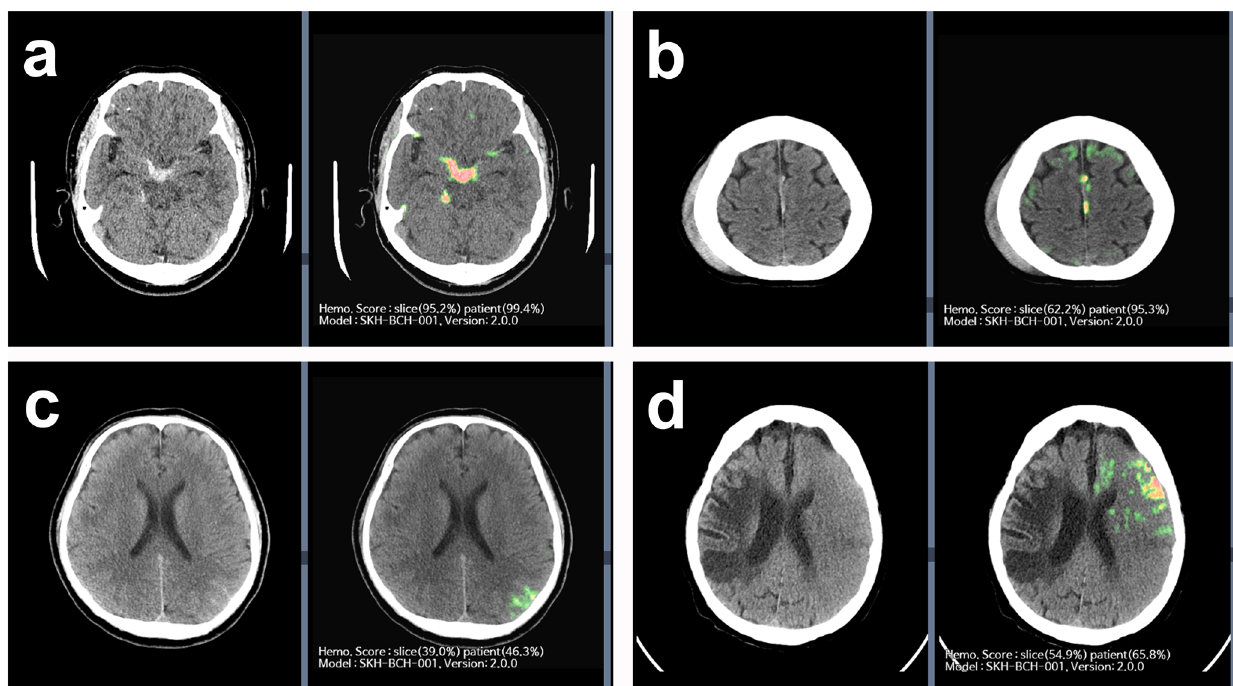
Fig. 3 Representative images of AIH detection. a AI-assisted brain CT revealed probable AIH location as the basal cistern and right ambient cistern. AI-assisted brain CT provided AIH probability scores in a slice-wise (95.8%) and patient-wise (99.4%) manner. All nine reviewers agreed with the AIH diagnosis for both AI-unassisted and AI-assisted interpretations. b AI-assisted brain CT revealed the probable AIH location as the left side of the falx. AI-assisted brain CT provided the AIH probability scores in a slice-wise (62.2%) and patient-wise (95.3%) manner. For interpretation without AI assistance, one reviewer (non-radiologist physician) missed this case of AIH on the left side of the falx. All nine reviewers agreed with the AIH diagnosis for both AI-unassisted and AI-assisted interpretations. c AI-assisted brain CT revealed probable AIH location as the left parietal sulci. AI-assisted brain CT provided AIH probability scores in a slice-wise (39.0%) and patient-wise (46.3%) manner. For interpretation without AI assistance, two-thirds of the reviewers (three non-radiologist physicians, two board-certi fi ed radiologists, and one neuroradiologist) missed this case of AIH in the left parietal sulci. With the use of AI assistance, these six reviewers were able to correctly revise their decisions. d AI-assisted brain CT revealed the probable AIH location as the left frontal area. AI-assisted brain CT provided the AIH probability scores in a slice-wise (54.9%) and patient-wise (65.8%) manner. For the interpretation without AI assistance, one-third of the reviewers (one non-radiologist physician and two board-certi fi ed radiologists) reported it as an AIH. With the use of AI assistance, an additional one-third of the reviewers (one non-radiologist physicians, one board-certi fi ed radiologist, and one neuroradiologist) reported this as an AIH. However, the subtle hyperattentuating lesion in the left frontal area was due to the beam-hardening artefact of the